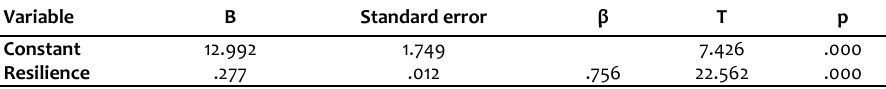
Table 21. Results of Simple Linear Regression Analysis Regarding Prediction of Science Process Skills of the 5- Year-Old Preschoolers Variable B Standard error β T p Constant